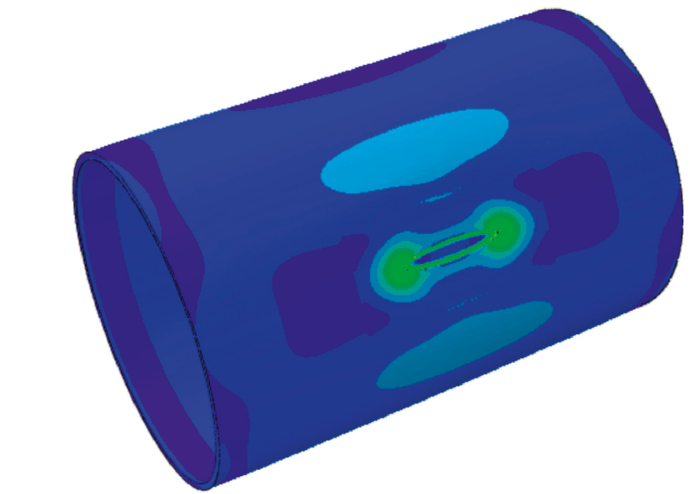
Figure 6: Stress nephogram of the flawless